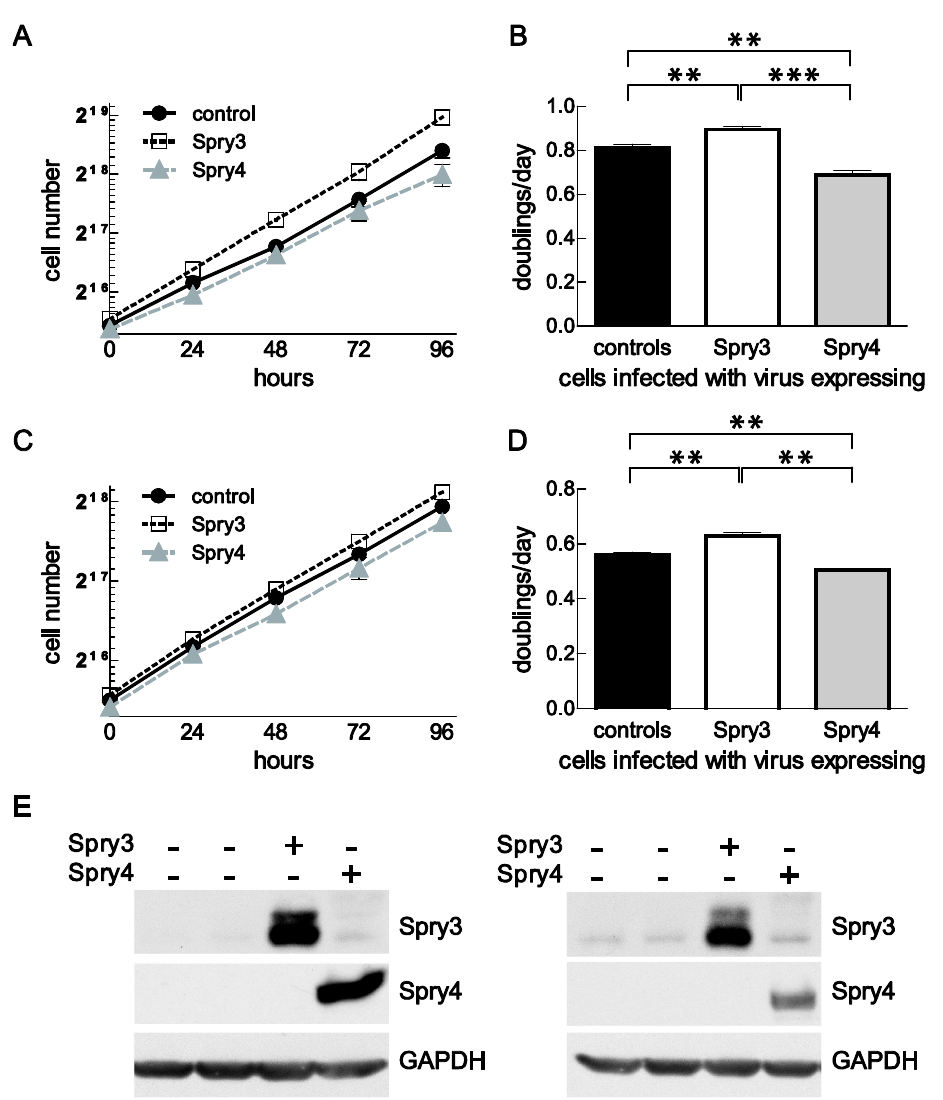
Figure 4. Influence of ectopic Spry3 and Spry4 expression on cell proliferation. Proliferation of cells overexpressing the indicated proteins was assessed by growth curve analysis. ( A ) The number of DBTRG-05MG cells were counted every 24 h for 5 days and are depicted as growth curves using a semi-logarithmical scale. A representative growth curve of three replicates is depicted. ( B ) Using GraphPad Prism, doubling times of at least three independent growth curve analyses performed with DBTRG-05MG cells were calculated and presented as mean doublings per day ± SEM. ( C ) A representative growth curve of U373 cell line is shown. ( D ) Using exponential growth equations, doubling times of U373MG cells were calculated and shown as doublings per day. Significance was assessed using an unpaired t-test in GraphPad Prism and mean ± SEM are shown. * p < 0.05; ** p < 0.01; *** p < 0.001 ( E ) Overexpression of Spry3 and Spry4 in the GBM cell lines DBTRG-05MG (left) and U373 (right) were verified by